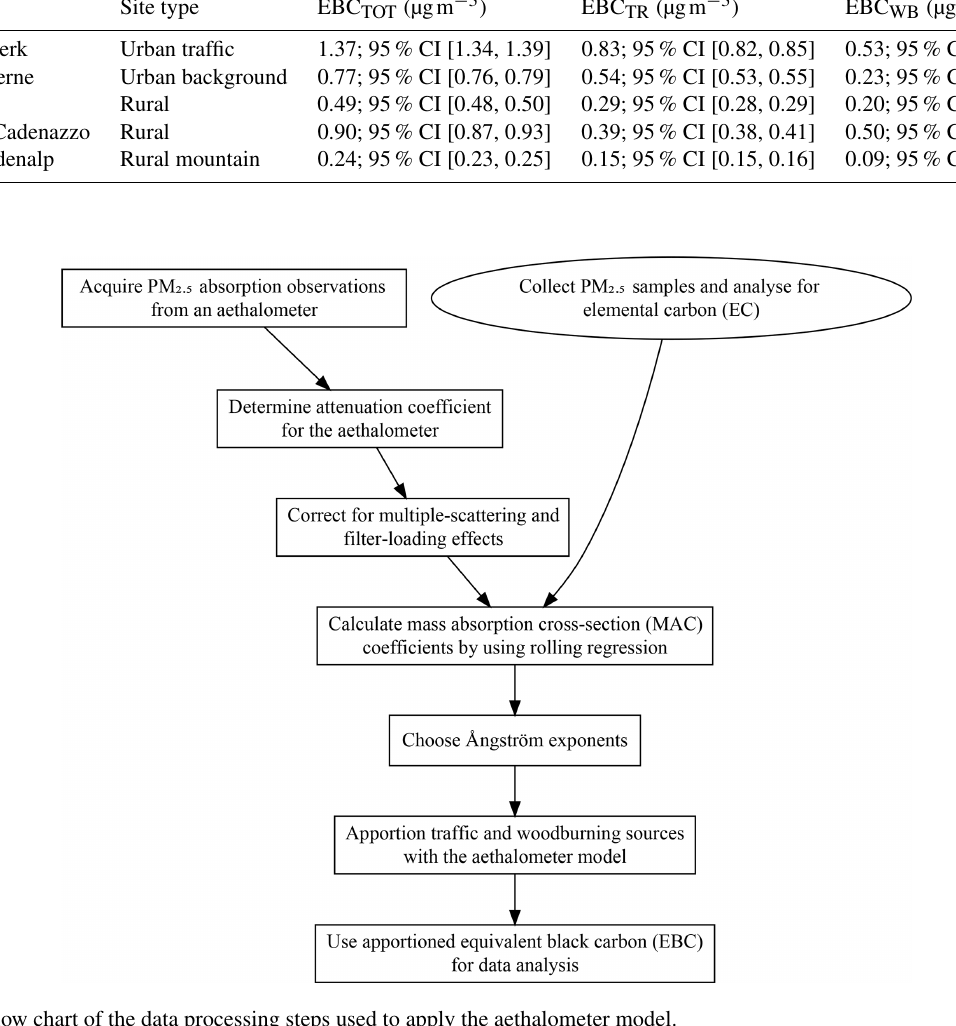
Figure A1. A flow chart of the data processing steps used to apply the aethalometer